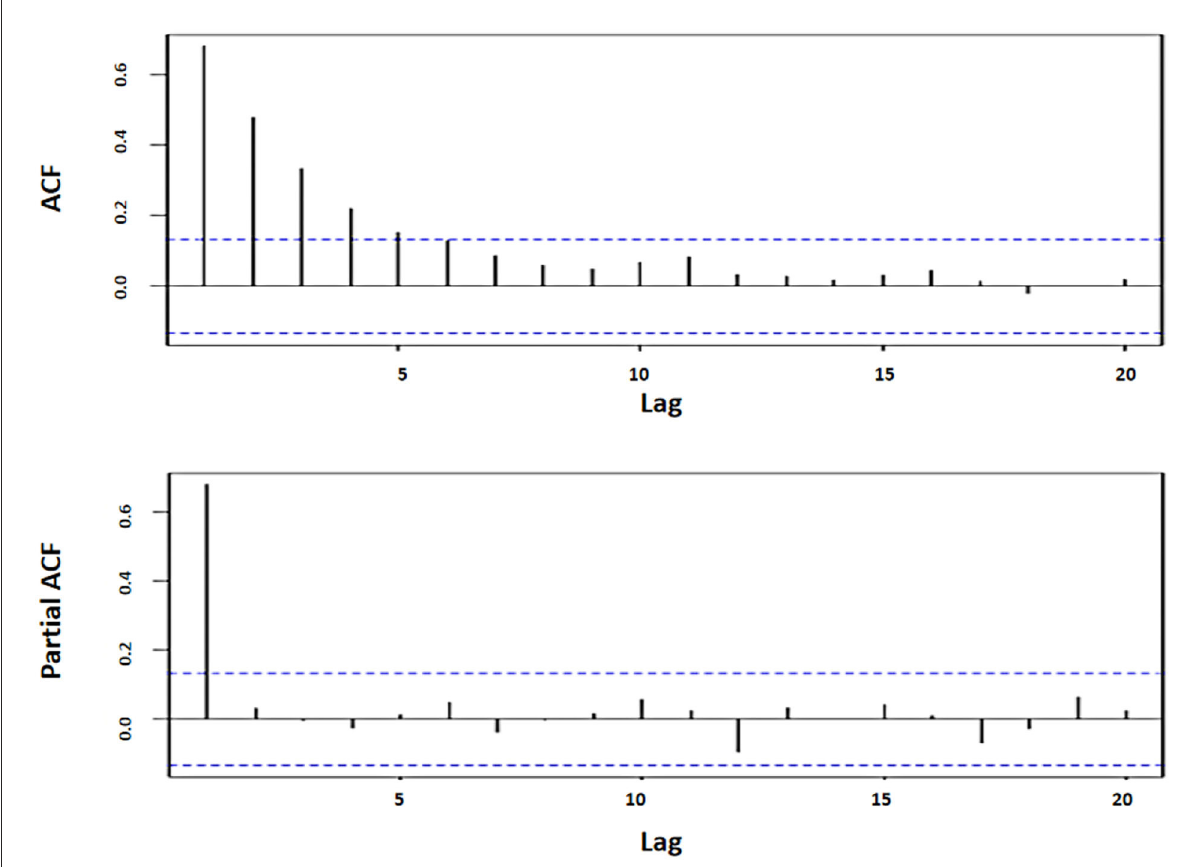
FIGURE5 ACF and PACF plots of WTI oil